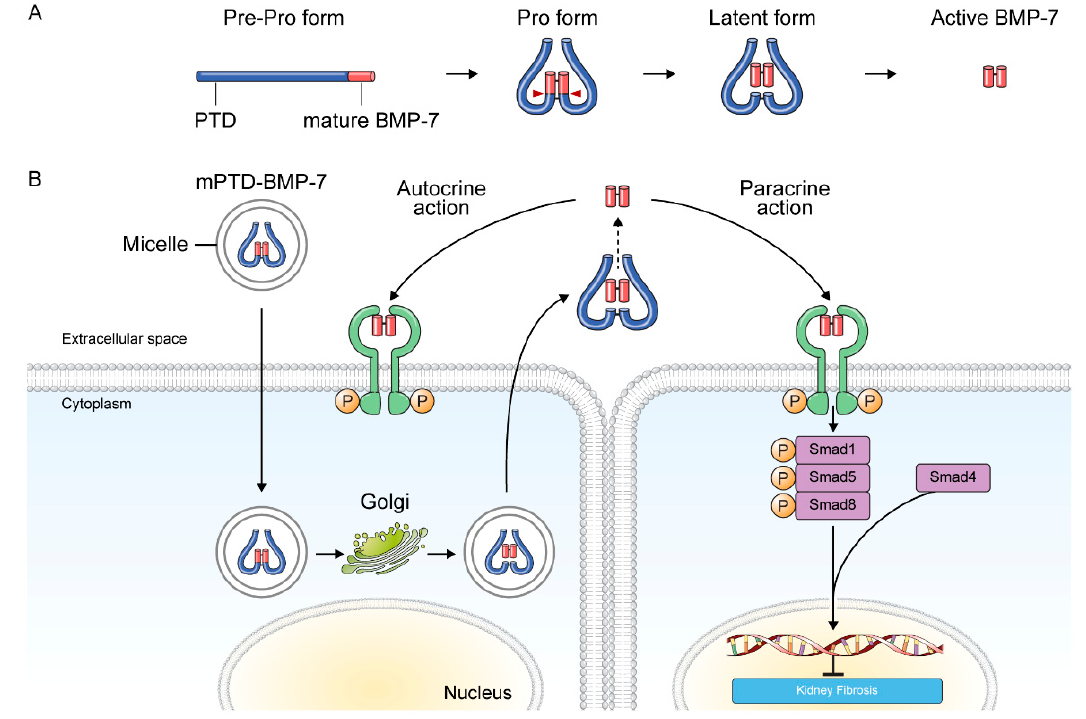
Figure 3. Delivery and action mechanism of mPTD-BMP-7. ( A ) Schematic diagram and preparation of PTD-BMP-7. ( B ) mPTD-BMP-7 is transduced into cells via an endosomal pathway, wherein it undergoes activation, followed by secretion. It functions in an autocrine and paracrine manner.